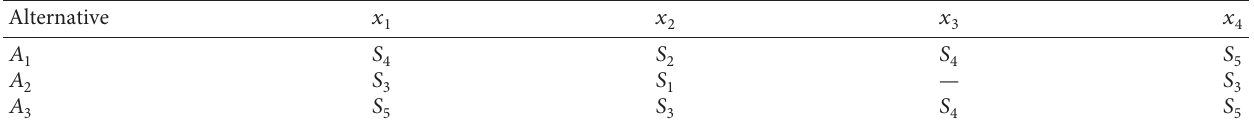
Table 22: The linguistic decision matrix provided by the second